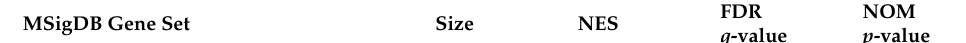
Table 2. Gene Set Enrichment Analysis (GSEA) results according to the MSigDB Hallmark gene sets.